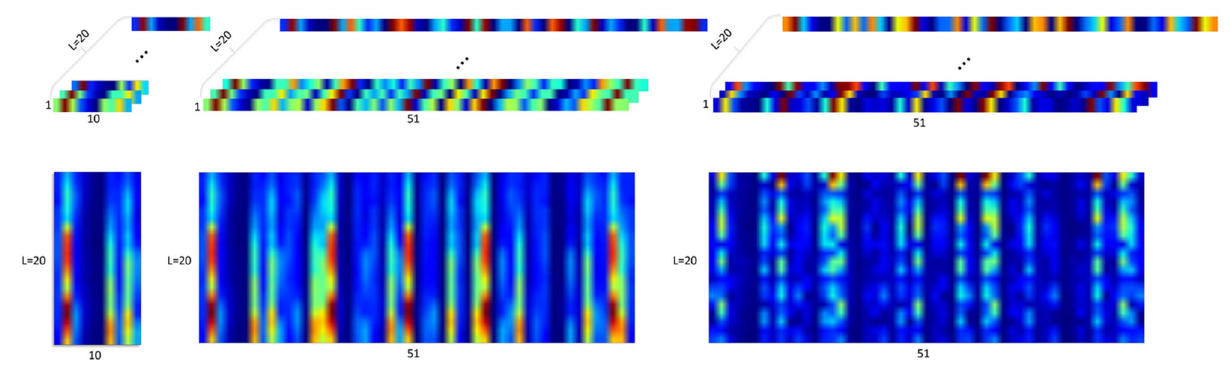
Frontiers in Neuroscience |